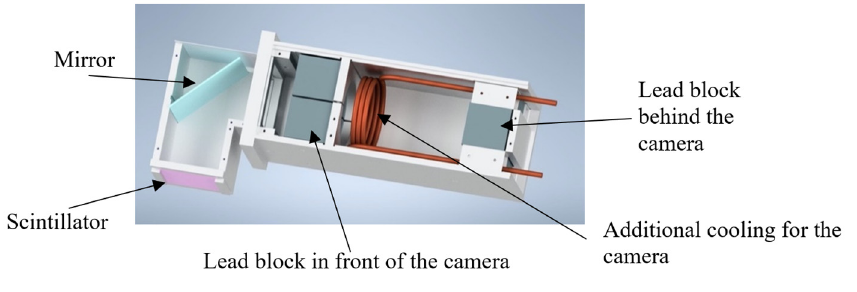
Figure 2. Model of the neutron imaging detection system without the camera. A photo of a NIFFLER facility placed at the end of the radial beamline of the training reactor VR-1, with some additional shielding made of lead and borated PE, is shown in Figure 3.